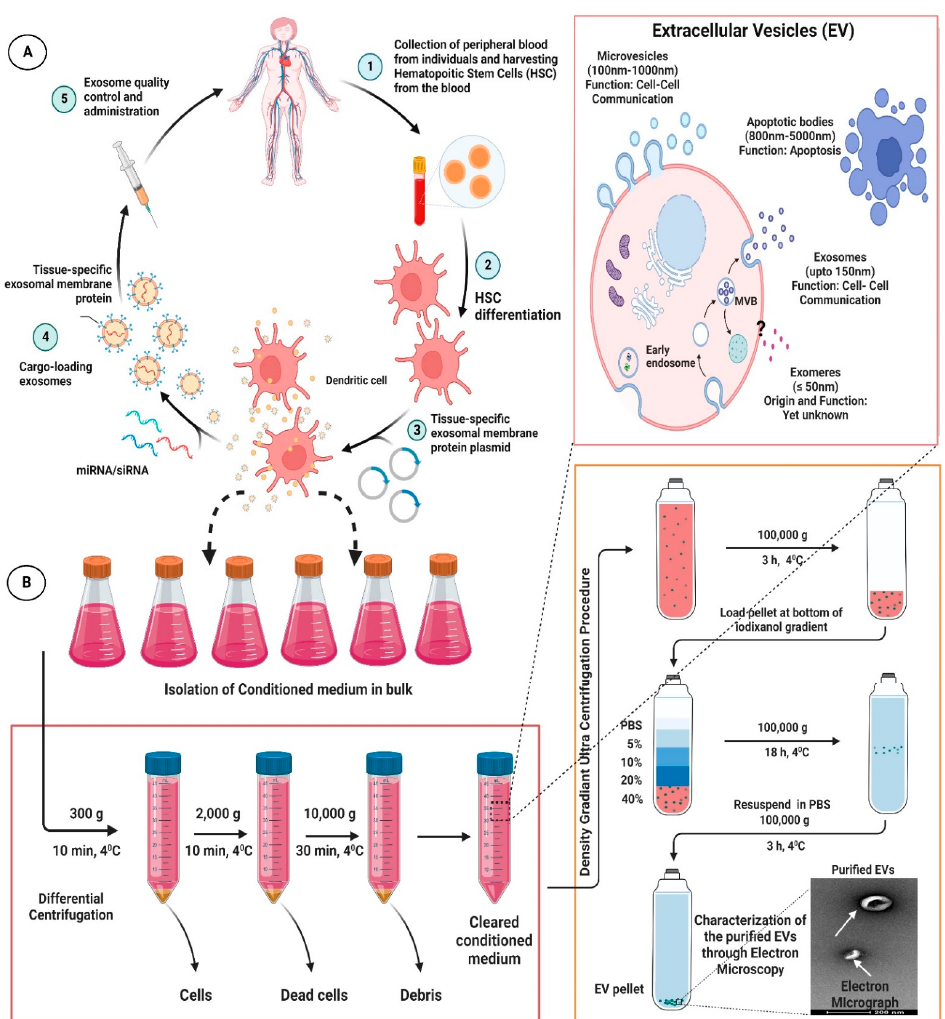
Figure 2. Representative figure highlighting the procedures for generation of engineered/modified exosomes for specific targeting of the therapeutic molecules to desired tissue ( A ) along with the workflow of differential ultracentrifugation for exosome isolation ( B ). The figures are prepared with the BioRender Software (biorender.com).